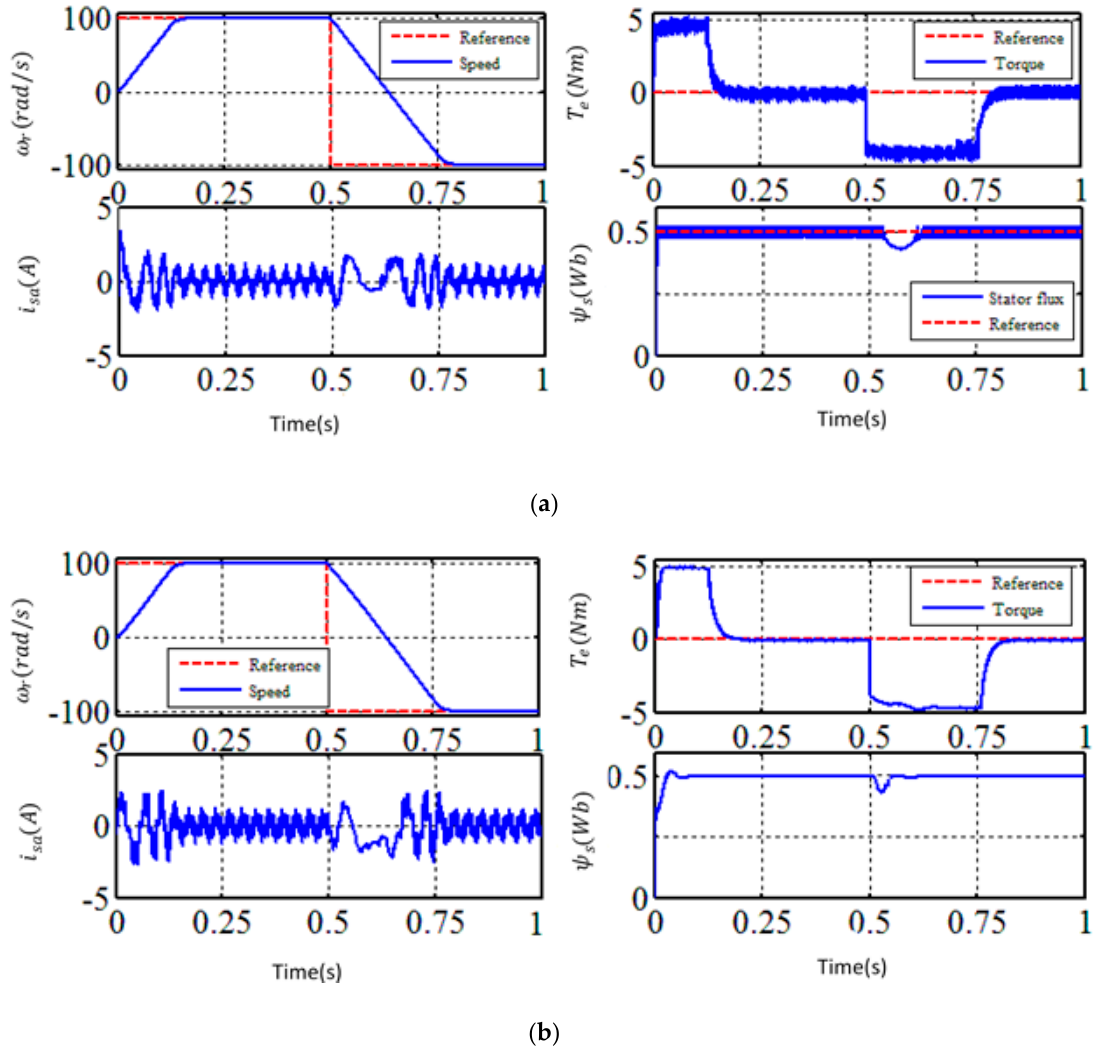
Figure 8. Speed direction change condition of the 6PIM controlled by the duty cycle control strategy ( a ) and proposed method ( b ).